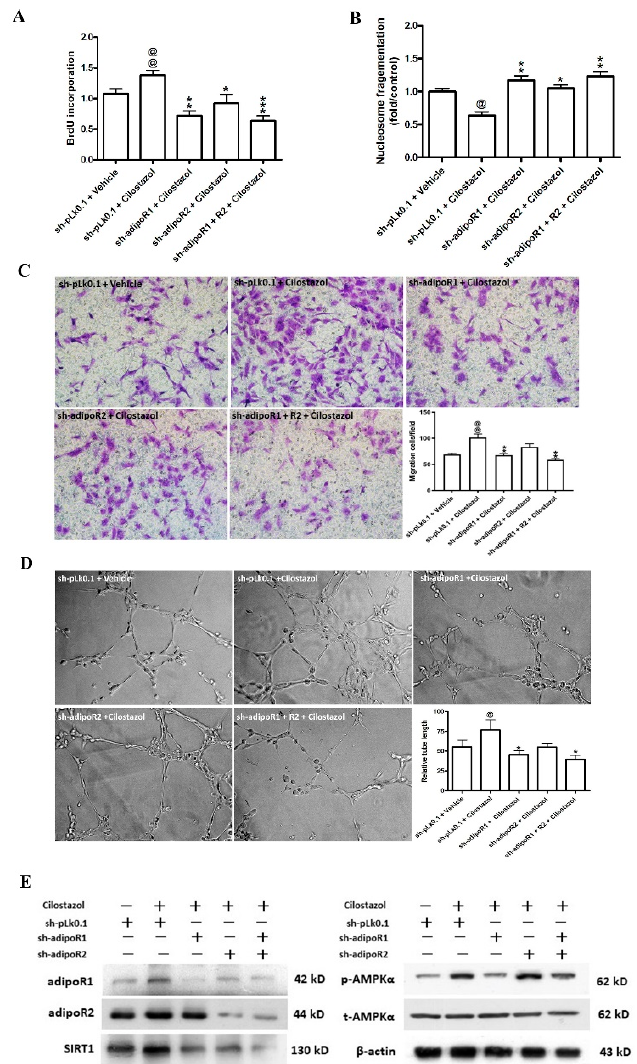
Figure 2. Knockdown of adiponectin receptors attenuated the angiogenic functions of cilostazol in HG-treated HUVECs. AdipoR1 shRNA, adipoR2 shRNA, and control shRNA (pLk0.1) lentivirus were used to infect HUVECs. Then, the Transwell coculture system was incubated under HG conditions in the presence or absence of cilostazol (100 µM) on the undersides of the inserts for 24 h. ( A ) Quantification of BrdU incorporation. ( B ) Quantification of DNA fragmentation by cell death using ELISAs. ( C ) Representative images (×200) of migrating cells stained with crystal violet and their quantification. ( D ) Representative photomicrographs (×200) of the tube formation assays and quantitation of branching points. ( E ) Effects of adiponectin receptor knockdown on cilostazol-induced AMPK phosphorylation and SIRT1 activity. Representative images of Western blot analysis of cell lysates from HUVECs. The results are represented as the mean ± S.E.M. from triplicate wells in three experiments. @ p < 0.05 and @@ p < 0.01 versus the vehicle group; * p < 0.05, ** p < 0.01, and *** p < 0.001 versus the sh-pLk0.1 group treated with cilostazol (100 µM).